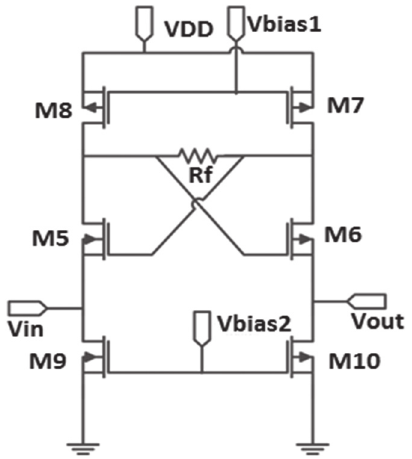
Figure 4 - Floating active inductor (Tao and Fa 2010).